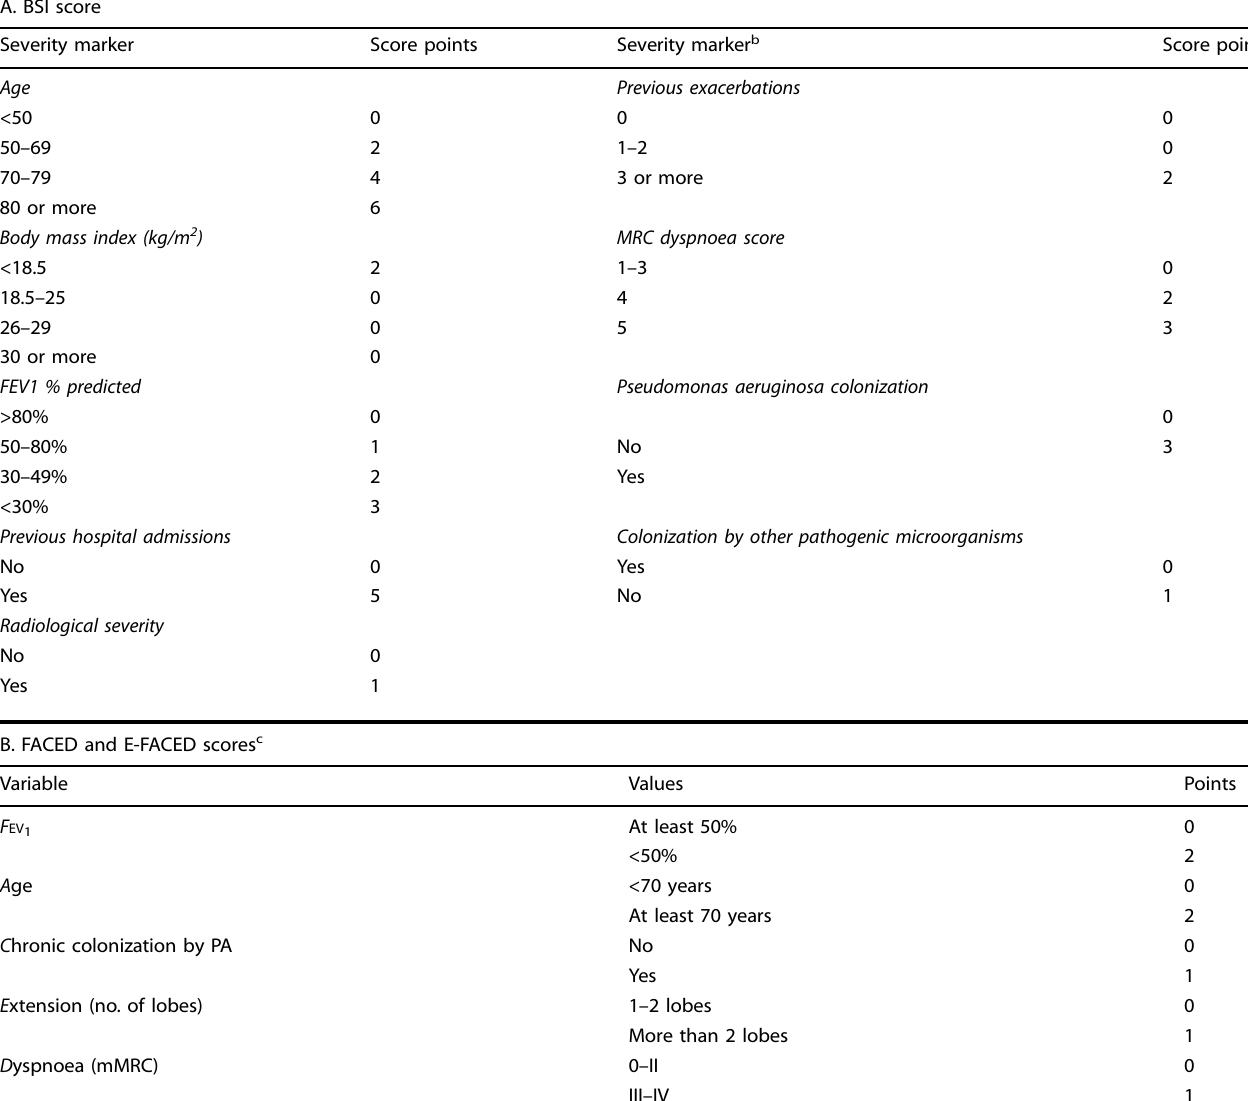
Table 1. Multidimensional scoring systems a